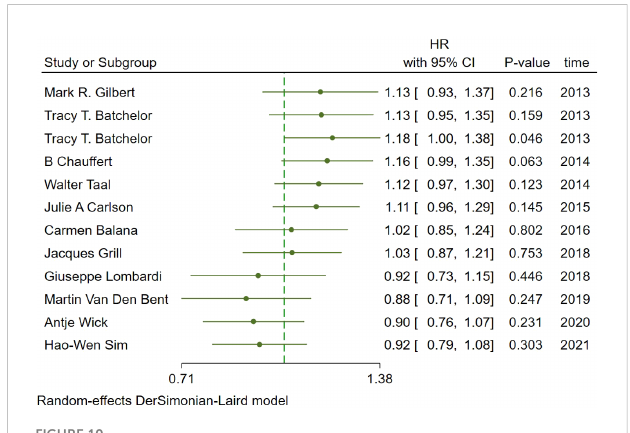
FIGURE 10 Cumulative meta-analysis of hazard ratios for overall survival (OS).